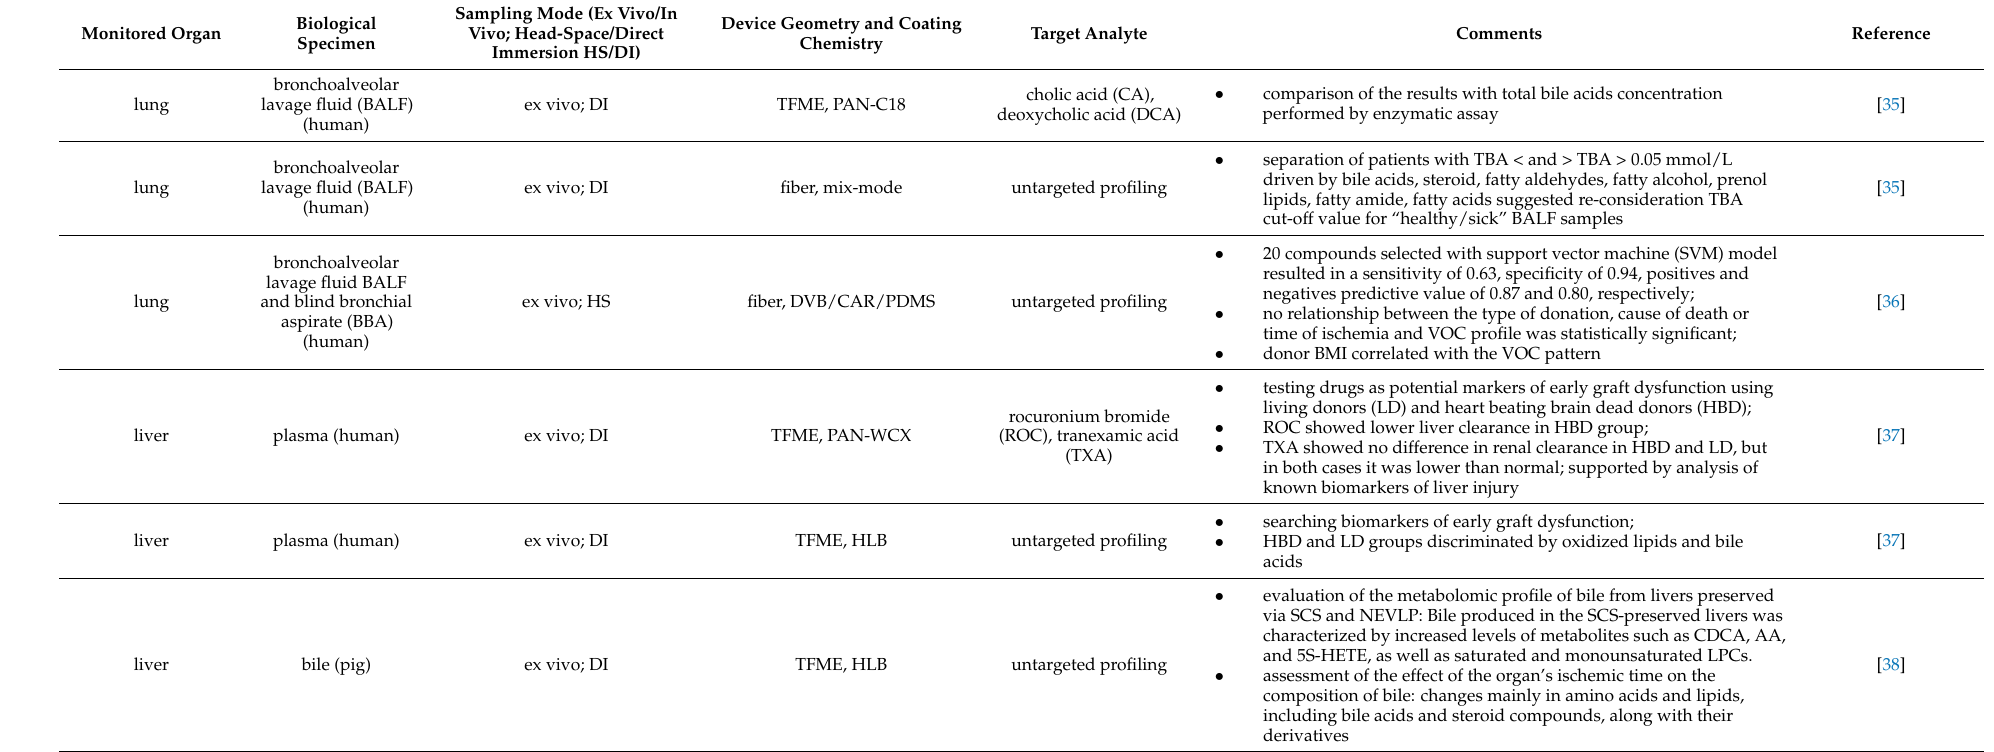
Table 1. Applications of solid-phase microextraction in solid organ